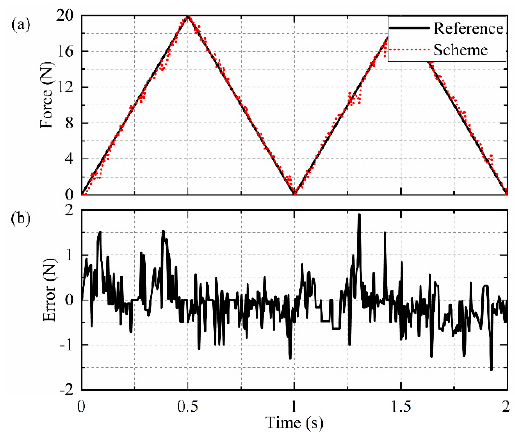
Figure 18. Experimental results of the triangular wave: ( a ) Force; ( b ) Force error.